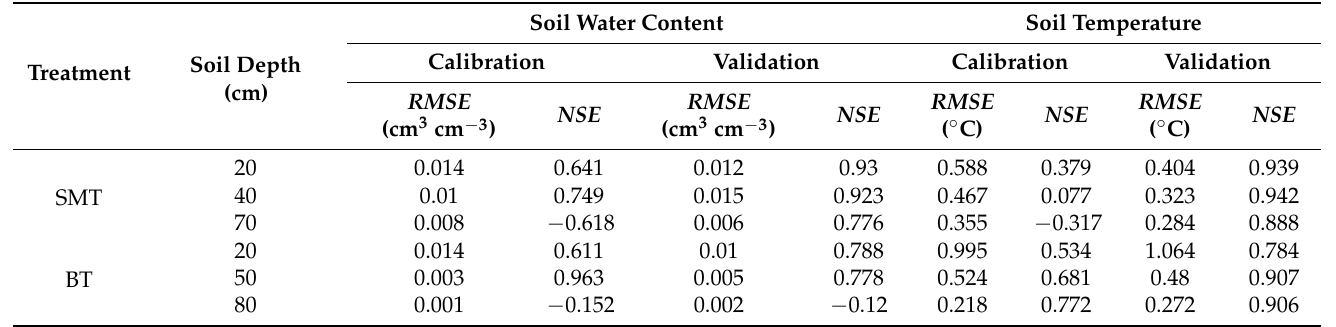
Table 4. Model performance results for simulated soil water contents and